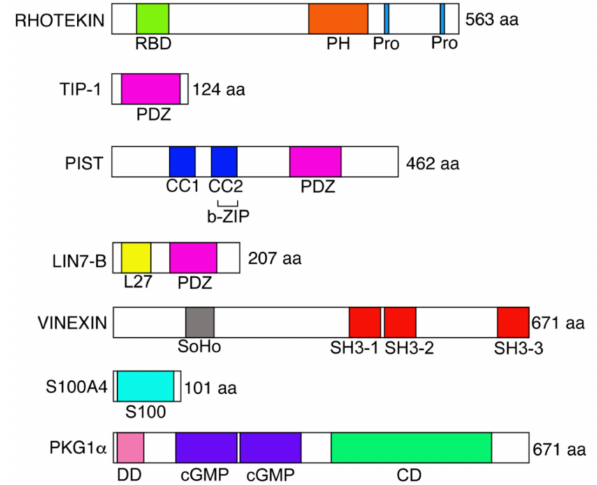
Figure 1. Structures of Rhotekin and its binding partners. Structural domains of proteins are abbreviated as follows: RBD, Rho-binding domain; PH, pleckstrin-homology; Pro, proline-rich motif; CC, coiled-coil domain; b-ZIP, basic leucine zipper domain; L27, Lin-2 and Lin-7 domain; PDZ, PSD-95/Discs large/Zona occludens-1 domain; SoHo, sorbin homologous domain; SH3, src homology 3 domain; S100, S100 domain; DD, dimerization/docking domain; cGMP, cyclic